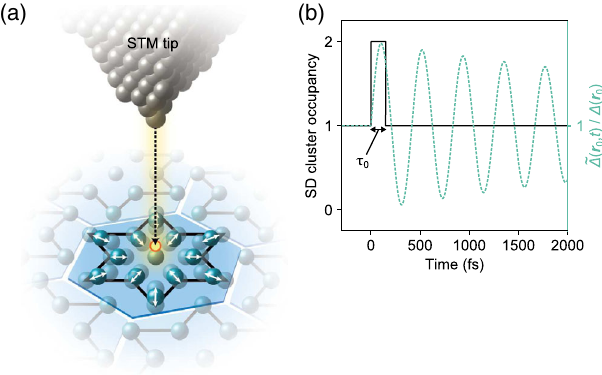
FIG. 5. Excitation of CDW amplitude mode by a transient doublonlike excitation. (a) A depiction of the excited amplitude mode in the SD cluster. (The Ta ionic displacements are greatly exaggerated.) (b) A qualitative plot of the SD cluster occupancy as a function of time, and the resulting local fluctuation of the order